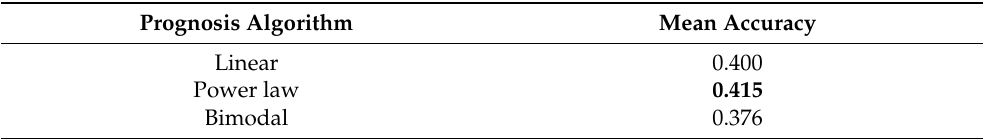
Figure 4. Remaining useful life estimates over time, along with the ground truth and an illustration of the computation of the corresponding α - λ -accuracy. Table 1. Comparison of the accuracy of the prognosis algorithms based on the three corrosion models. Highest mean accuracy in